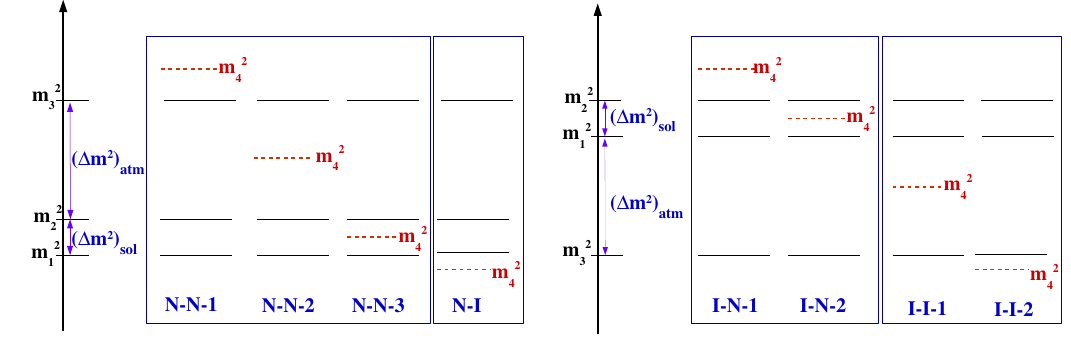
Figure 1 . Graphical representations of the mass ordering con(cid:12)gurations given in table